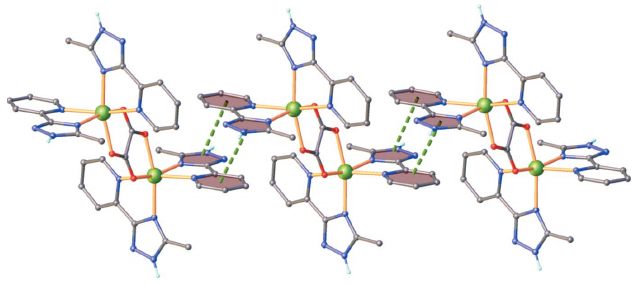
Figure 3 (cid:2) - - (cid:2) stacking between adjacent complex cations. Centroid-to-centroid contacts are shown as green dashed lines.